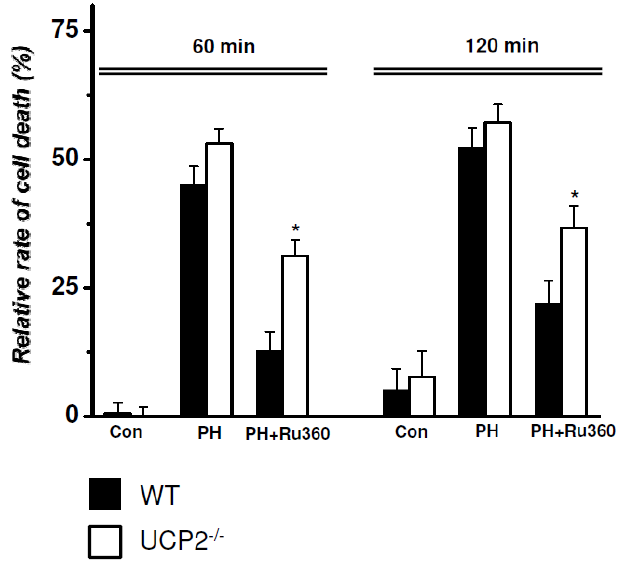
Figure 2. Relative rate of cell death (RRCD) defined as the percent of the difference in CV at 0 min and at X min normalized to CV at 0 min in WT vs. UCP2 −/− cardiomyocytes after 0, 60 and 120 min. Con = cells stored in control solution; PH = pelleting hypoxia; PH+Ru360 = pelleting hypoxia previously incubated with Ru360 (10 µM); * p < 0.05 vs.